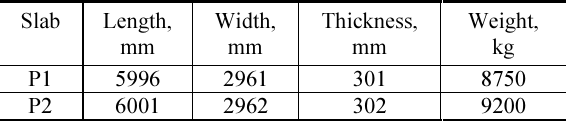
Fig. 2. Plastic inserts of the slab: a) insert; b) insert fixing